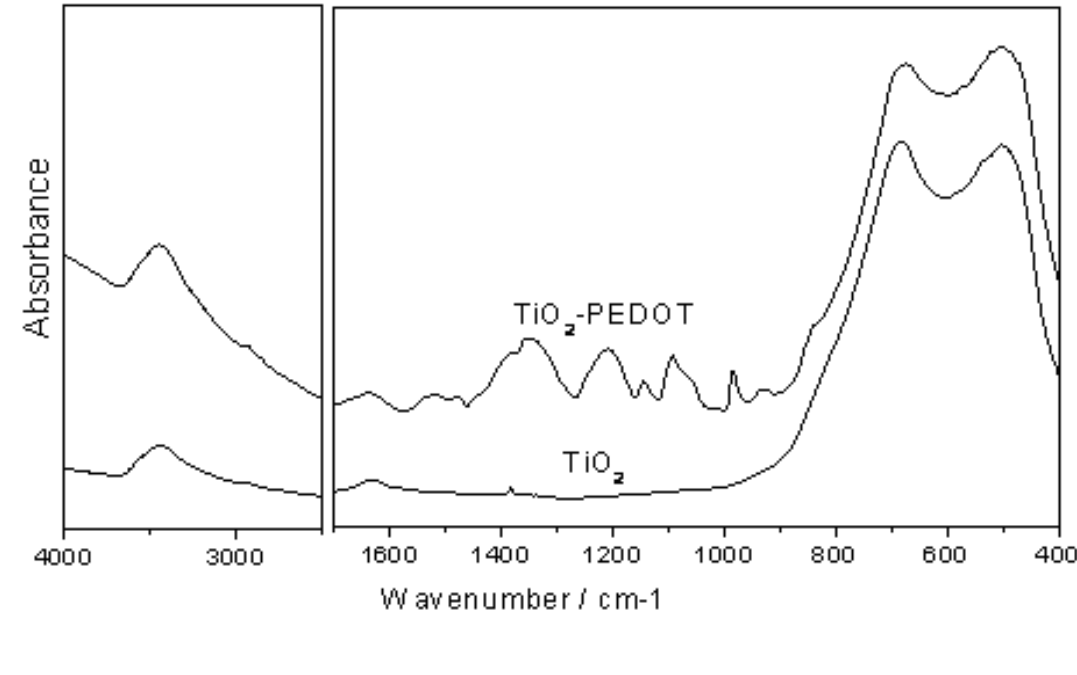
nanofibers and TiO 2